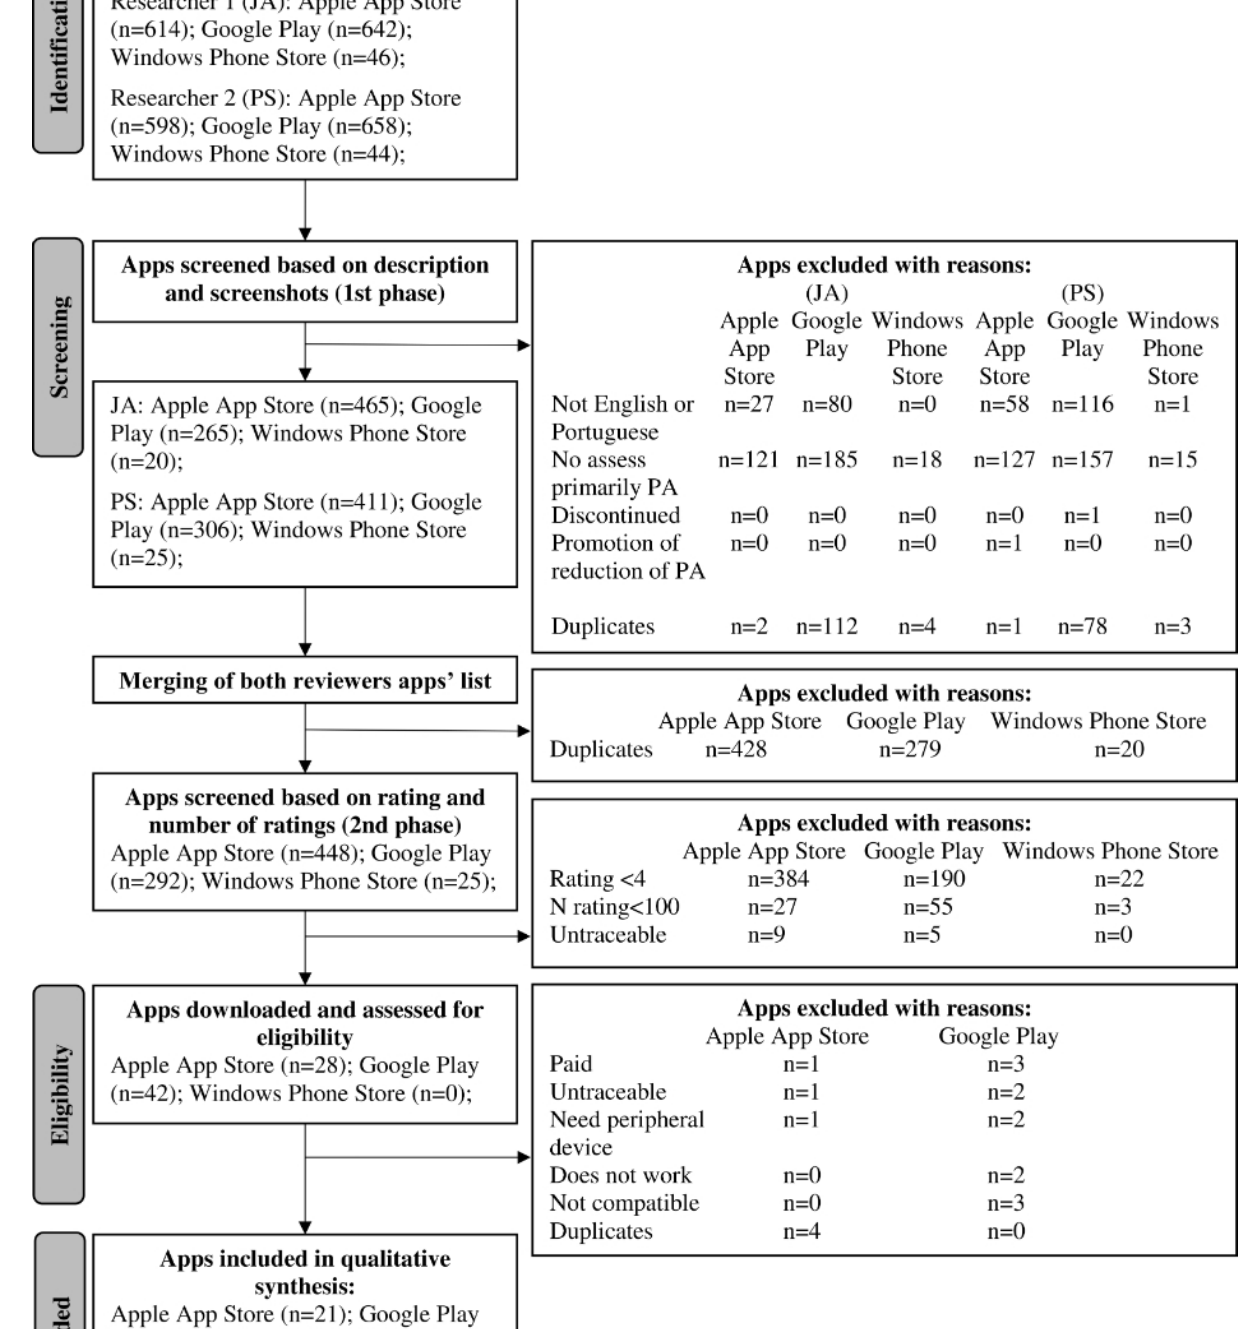
Figure 1. Flowchart of the selection process for apps included in the study. PA: physical